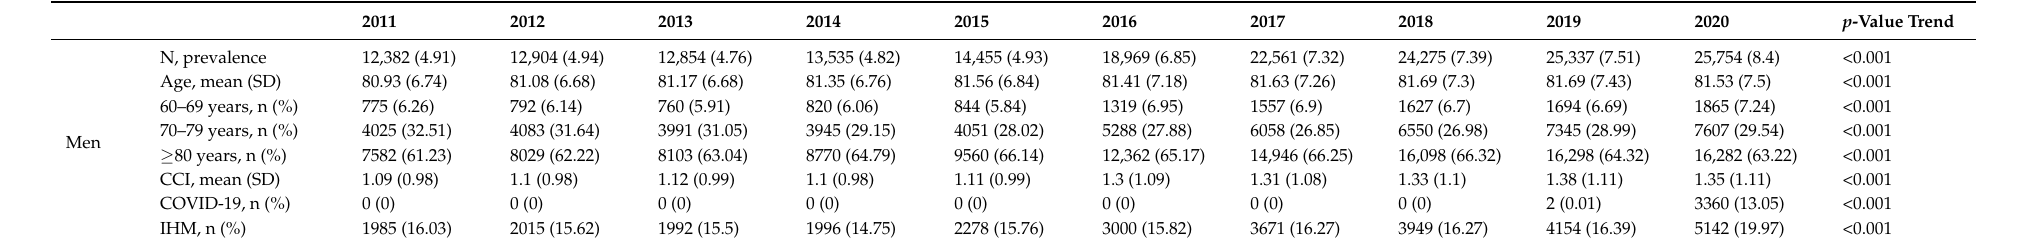
Table 2. Prevalence of all-cause dementia. Distribution by age and clinical characteristics and in-hospital outcomes among men and women hospitalized with type 2 diabetes in Spain,